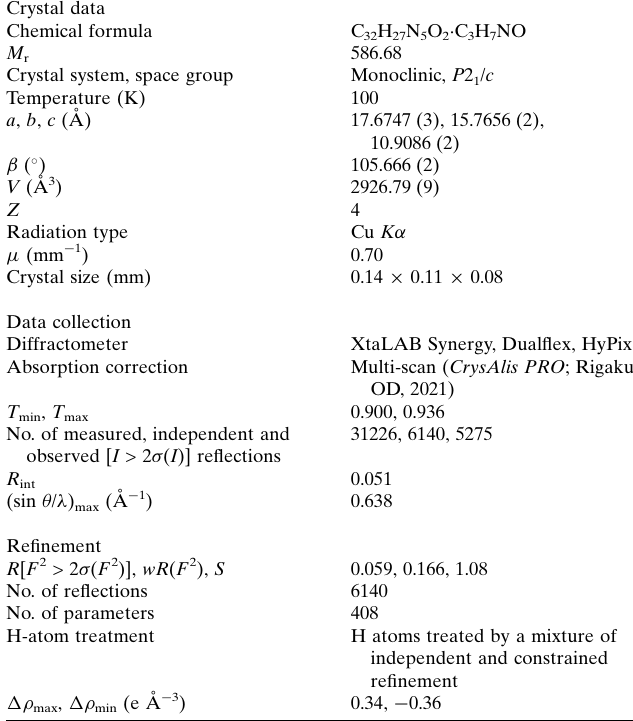
Table 2 Summary of short interatomic contacts (A˚ ) in the title compound. Atoms Distance Symmetry code